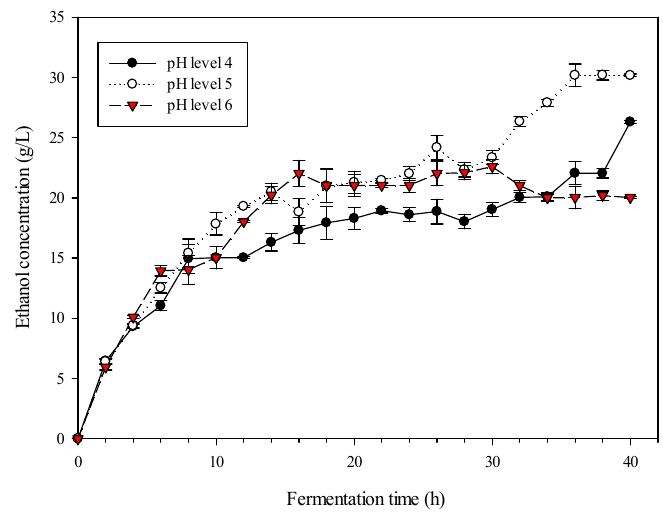
Figure 8. Effect of pH level on the fermentation of treated Napier grass, using a four - blade turbine impeller at 30 °C, an agitation speed of 70 rpm, and 2 wt % yeast .